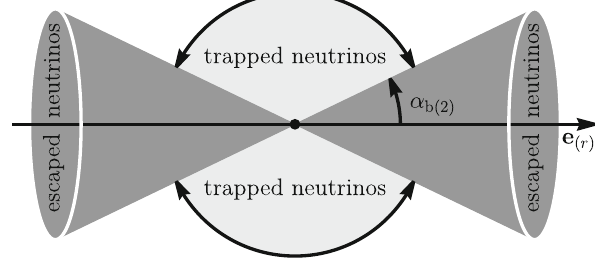
Fig. 5 Visualization of the escaping/trapping